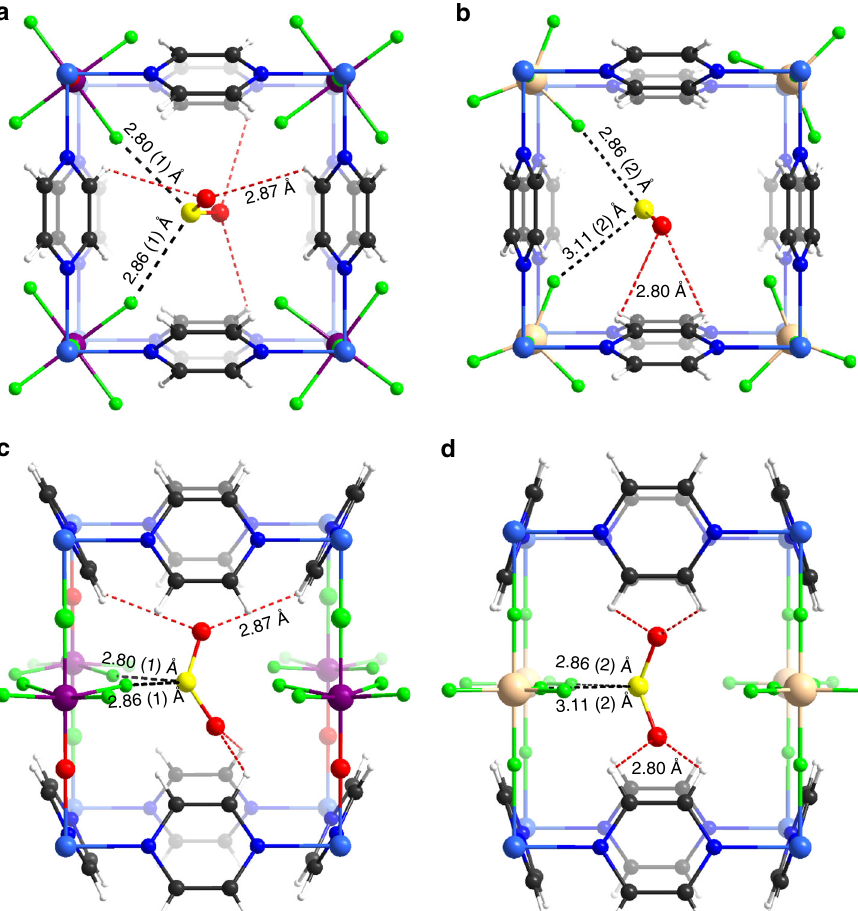
Fig. 2 In situ visualization of SO 2 in host frameworks. Intermolecular host – guest interactions in SO 2 loaded crystal structures of a , c KAUST-7 and b , d